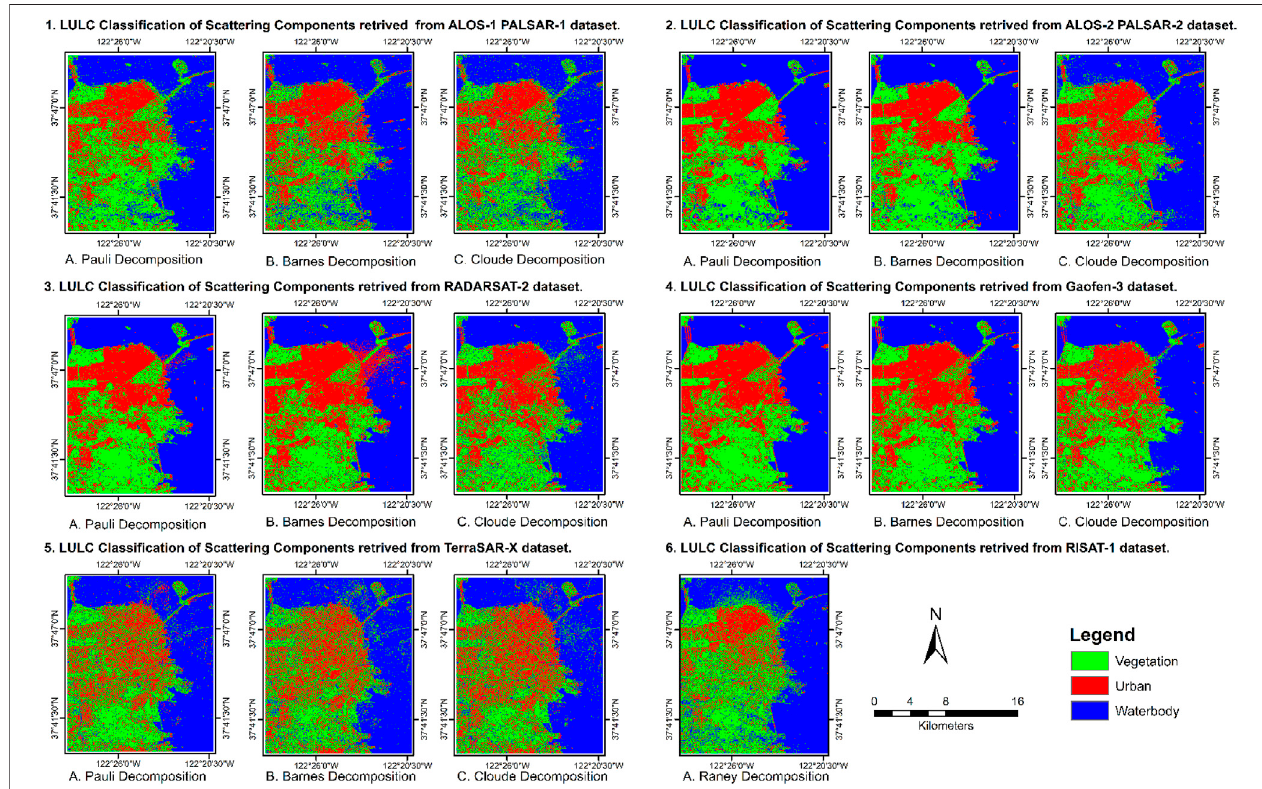
FIGURE 10 | LULC images obtained from classi fi cation of Pauli, Barnes, Cloude scattering components extracted from multi-temporal and multifrequency datasets; Green — vegetation, Red — urban, and Blue — waterbody.